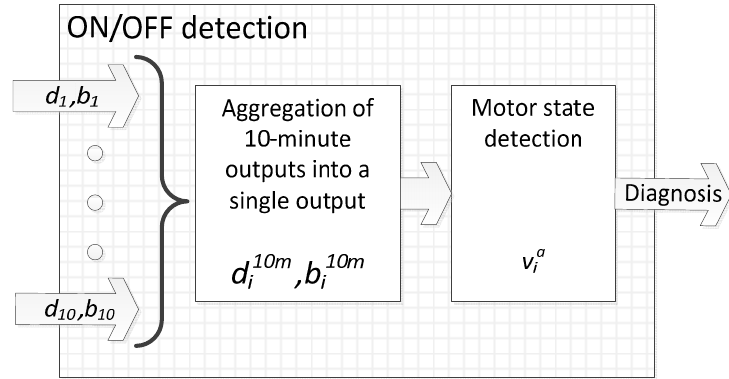
Figure 5. Block diagram of the ON-OFF algorithm.